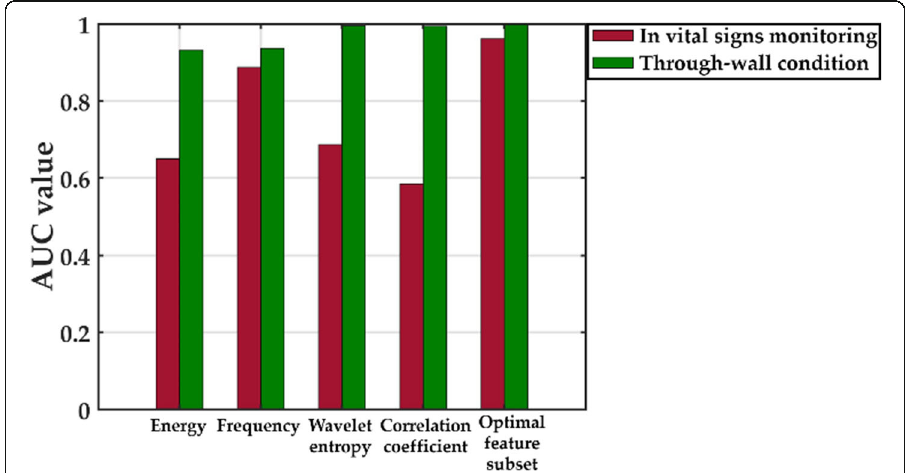
Fig. 13 Comparison of the role of different categories played in through-wall conditions and in-home